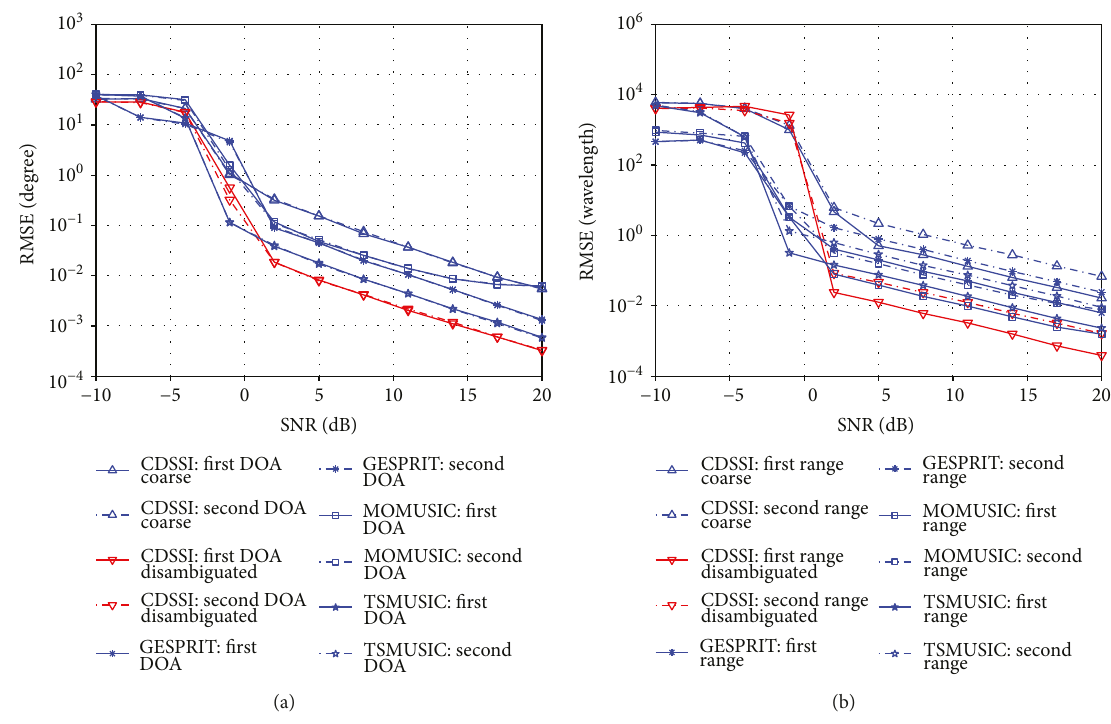
Figure 10: RMSEs of DOA and range estimates versus